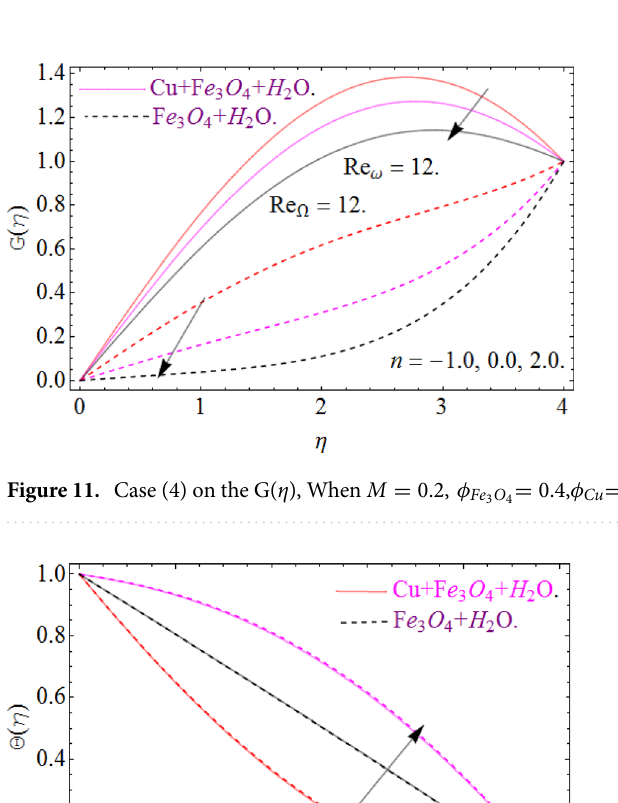
Figure 10. Case (3) on the G( η ), When M = 0.2, φ Fe 3 O 4 = 0.4, φ Cu = 0.2, Ec = 0.1, Pr = 6.2 .